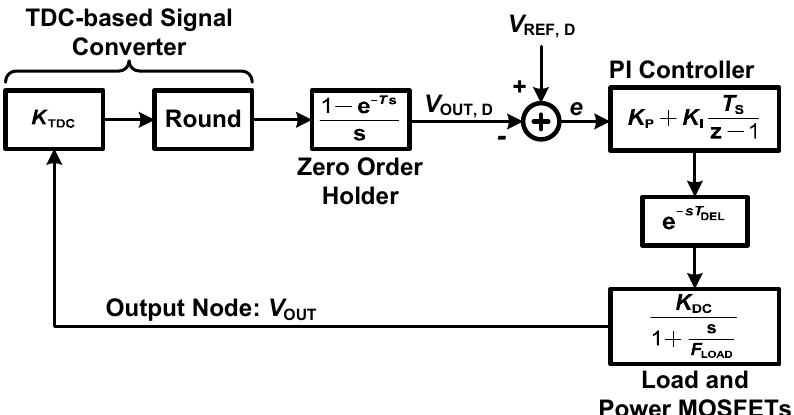
Figure 2. The system hybrid model for the proposed DLDO.